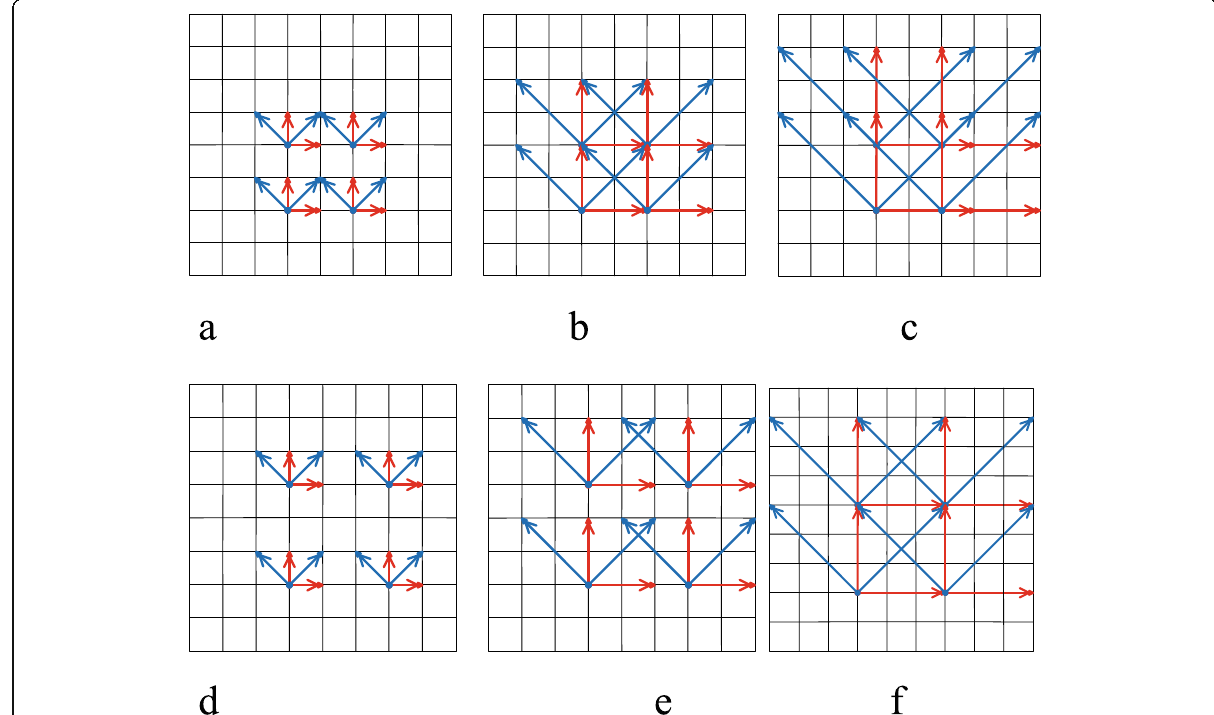
Fig. 5 ASGLCM calculation on one slice of a volume, containing 13 directions in the 3D space: ( a ) stride = 2, displacement = 1, ( b ) stride = 2, displacement = 2, ( c ) stride = 2, displacement= 3, ( d ) stride = 3, displacement = 1, ( e ) stride = 3, displacement = 2, ( f ) stride = 3, displacement =